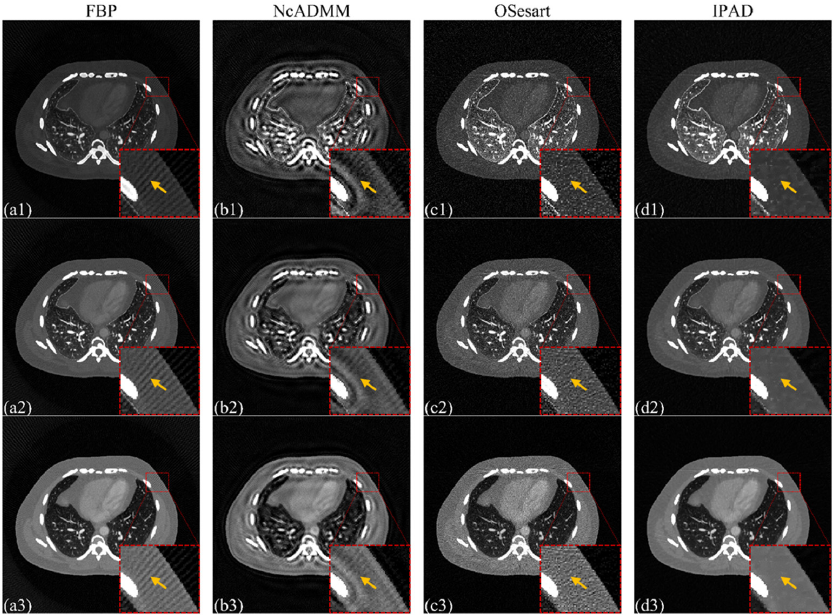
Figure 11. Virtual monochromatic images of thorax dataset at energy 40, 65, and 90 keV. ( a1 )–( a3 ), ( b1 )–( b3 ), ( c1 )–( c3 ), and ( d1 )–( d3 ) represent the virtual monochromatic images of FBP, NcADMM, ( b1 – b3 ), ( c1 – c3 ), and ( d1 – d3 ) represent the virtual monochromatic images of FBP, NcADMM,